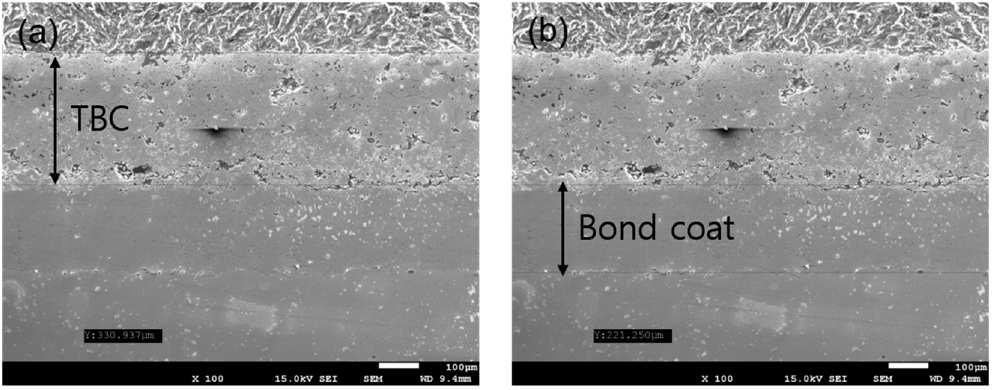
Figure 2. The scanning electron microscope images of a coated specimen: the measured thickness of ( a ) the thermal barrier coating (TBC) and ( b ) the bond coat.